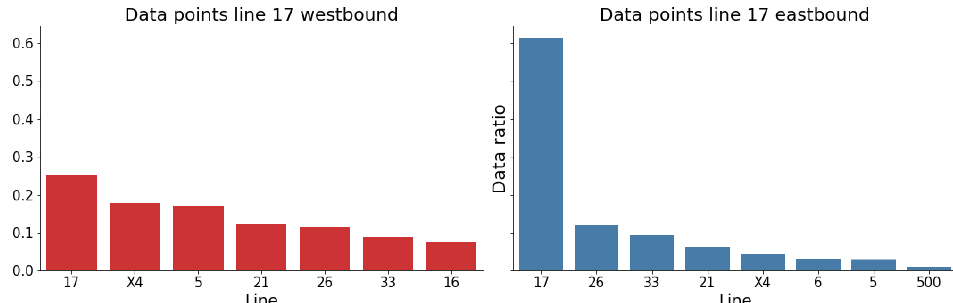
Figure 3. Ratio of data contribution for both directions an their interacting lines. Only those lines are shown which contribute more than 3% of data points in the area of interests as shown in Figure 2. Left shows the ratio of data points to the target line with origin from each of the included lines for the westbound direction. Right shows the ratio of data points to the target line for the eastbound direction.